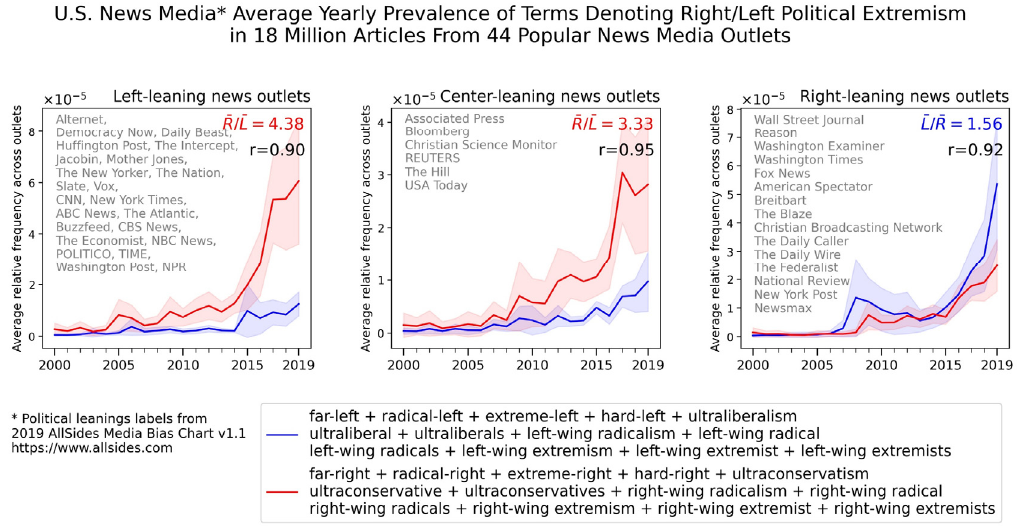
Figure 2. Average yearly prevalence of an aggregate set of terms denoting far-right (red) and far-left (blue) political extremism in 44 popular U.S. news media outlets arranged by outlets’ ideological leanings according to human ratings from AllSides Media Bias Chart 2019 v1.1 (AllSides 2019). Shaded areas indicate the 95% confidence interval around the mean. The average prevalence ratio between both time series ( R / L or L / R ) is color-coded according to which ratio is dominant. The Pearson correlation coefficient, r, of the time series is shown on the top right of each